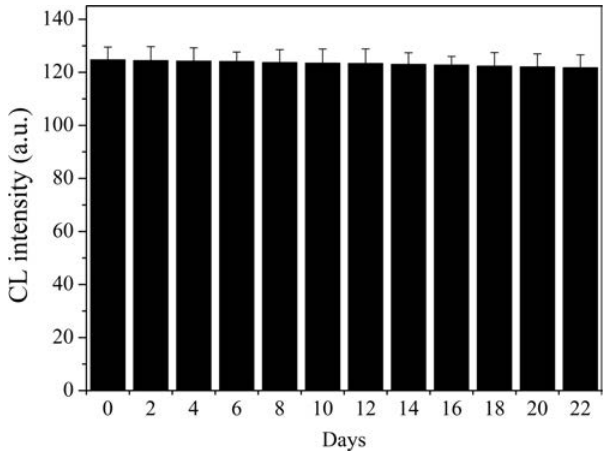
Fig. 9. Long-term stability of the presented devices